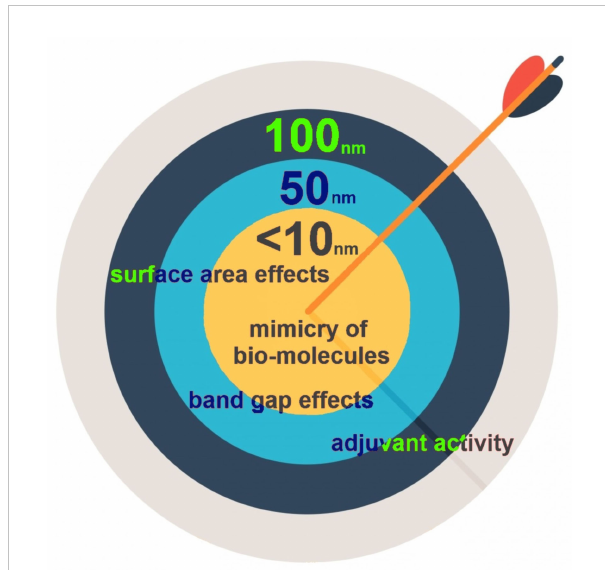
FIGURE 1 Factors in fl uencing cellular interactions. Nanoparticles within the conventionally de fi ned 1-100 nm size range have the potential to exert a wide range of immuno-suppressive and immune-stimulatory effects, with size, shape, charge, and surface composition all acting to in fl uence the outcome. Particles under 10 nm in diameter are able to interact directly with proteins that trigger biological responses, such as receptors (1, 2). Enhanced reactivity of very small particles results from having large surface areas and increased band gaps in their electronic con fi gurations (3). Particles larger still are effective carriers of antigen or other biologically active cargo to immune cells